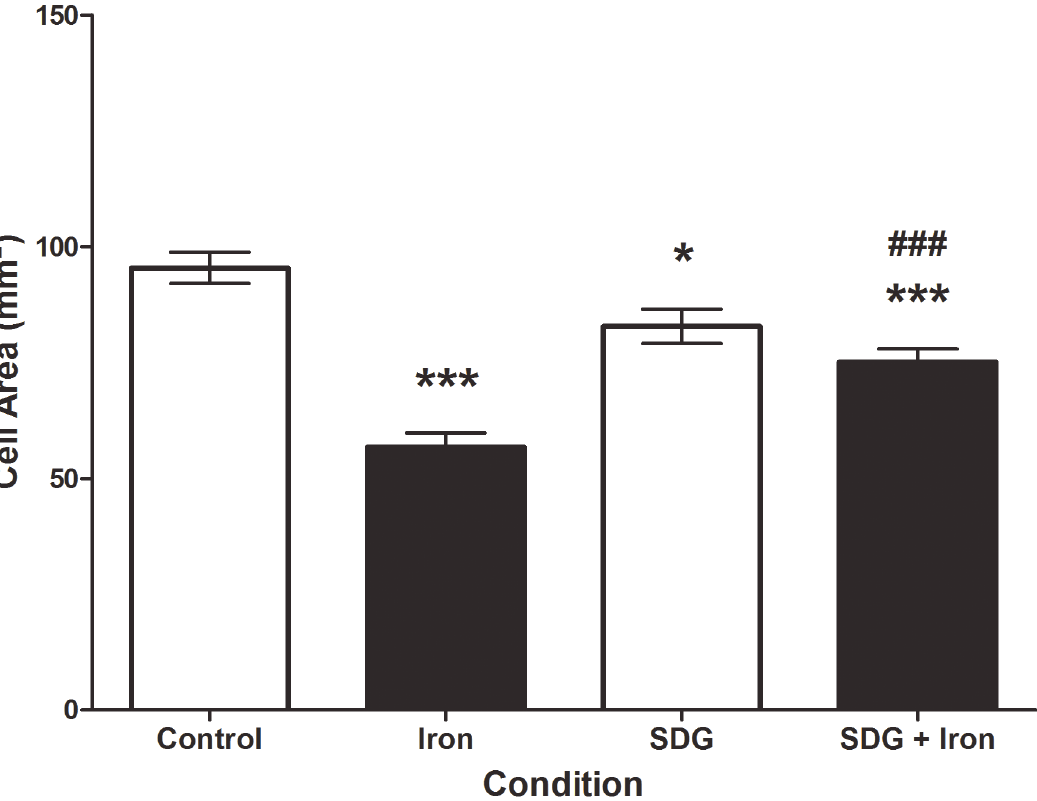
Fig 1. Pretreatment with SDG prevents iron induced decrease in H9c2 cell size. Cell surface area of control, 50 μ M iron-treated, 500 μ M secoisolariciresinol diglucoside (SDG), and SDG pre-treatment + iron-treated H9c2 cells. Cell surface area was assessed with ImageJ software. Data is expressed as mean cell area (mm 2 ) ( *** = p < 0.001 vs control; * = p < 0.05 vs control; ### = p < 0.001 vs iron, n = 10 images).